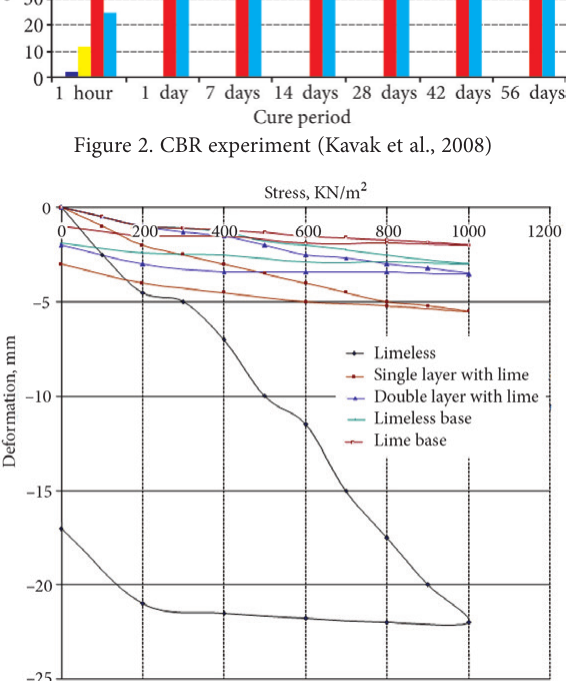
Figure 3. Graphical display of the plate loading experiments (Kavak et al., 2008)